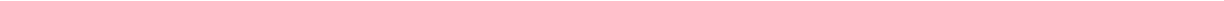
Fig. 4 Endoplasmic Hrd1 selectively sequesters mutant Blimp-1 proteins, and promotes their ubiquitination and cytoplasmic degradation. a HeLa cells co- expressing mCherry-Hrd1 with GFP-tagged WT or mutant Blimp-1 proteins were treated with MG132 for 24 h and observed under a confocal microscope. Scale bar : 10 μ m. b Hrd1 − / − 293T cells expressing GFP-tagged WT or mutant Blimp-1 proteins were treated with MG132 for 12 h and observed under a confocal microscope. Scale bar : 7.5 μ m. c Hrd1 − / − 293T cells co-expressing mCherry-Hrd1 with GFP-tagged WT or mutant Blimp-1 proteins were treated with MG132 for 12 h and observed under a confocal microscope. Scale bar : 7.5 μ m. d Flag-tagged WT or mutant Blimp-1 proteins were overexpressed in 293T cells, which were then treated with MG132 (20 μ M) or left untreated for 12 h. The extracts were co-immunoprecipitated with control IgG or an anti- fl ag antibody ( upper panel )/Hrd1 antibody ( bottom panel ). The co-immunoprecipitated lysates and extract input were then immunoblotted with